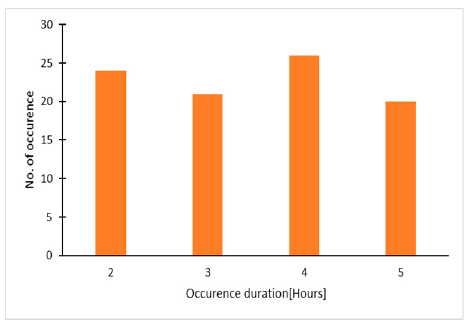
Figure 13. Special duration distribution.